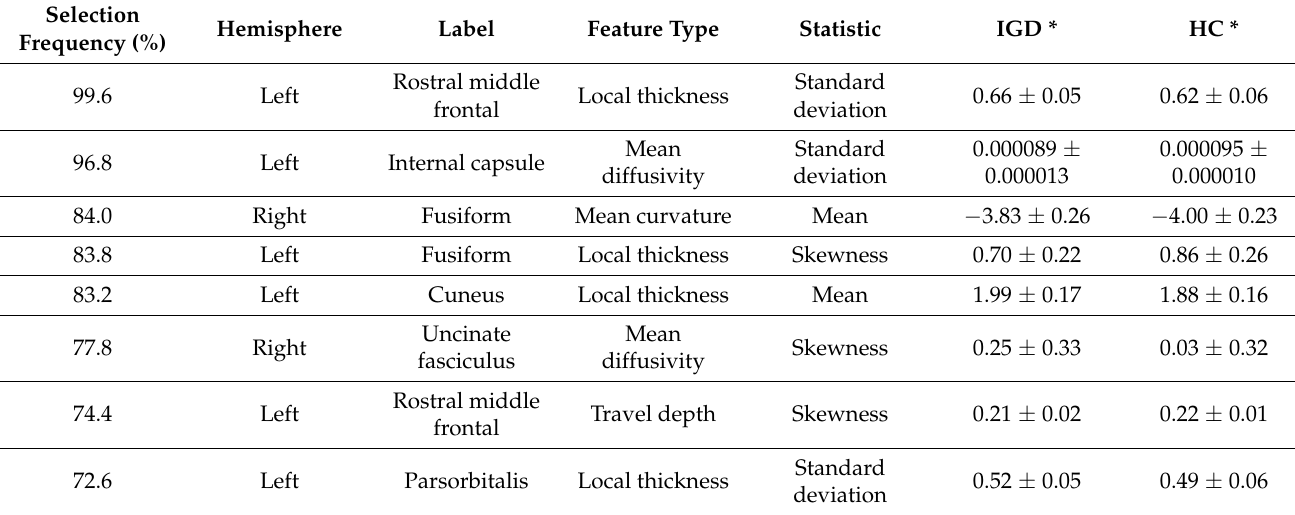
Table 3. Significant features for discriminating IGD and